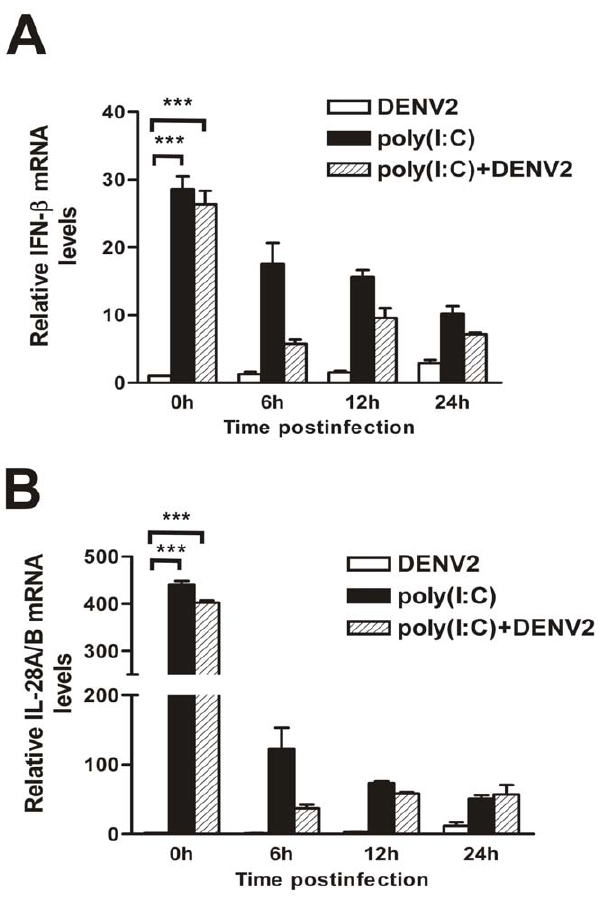
Figure 3. Expression of IFNs in mock-treated or poly(I:C) pretreated HepG2 cells. After pretreatment with poly(I:C) for 9 h, HepG2 cells were infected with DENV2 at an MOI 1. The cells were harvested at 0, 6, 12, and 24 h p.i. for RNA extraction and real-time RT- PCR for IFN- b (A) or IL-28A/B (B). Error bars represent the standard error of mean from the average of three experiments. Student’s t test, **, p , 0.01; ***, p , 0.001.